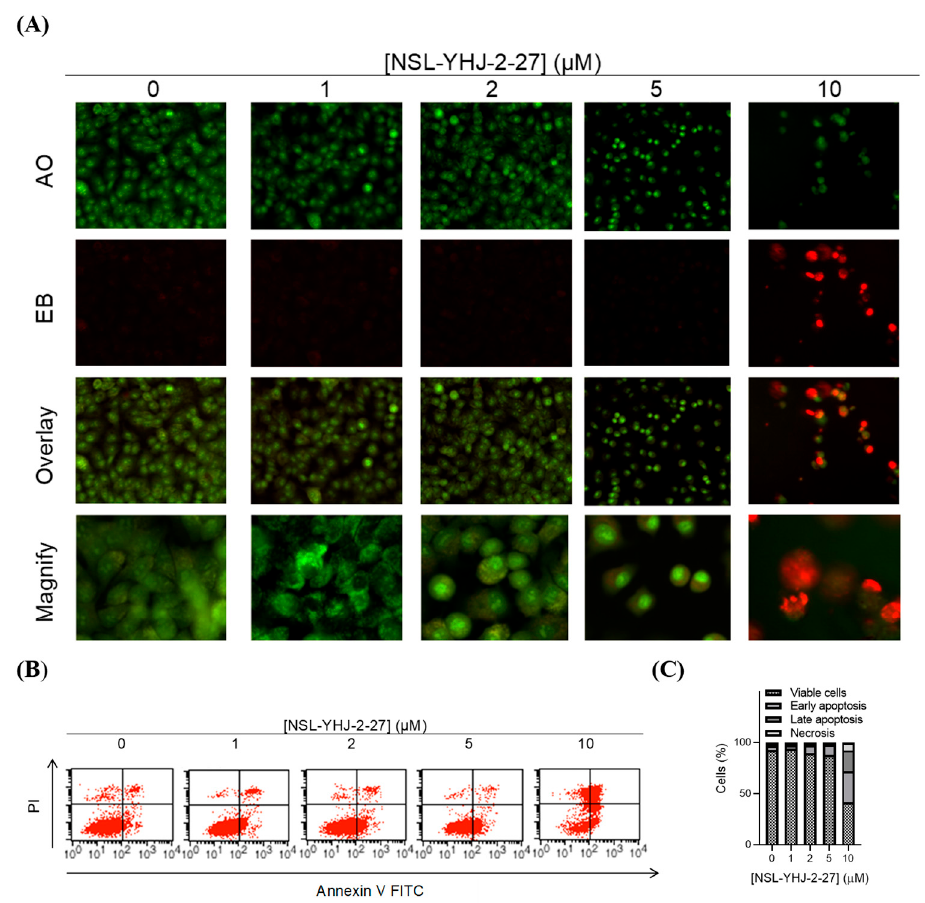
Figure 4. PCAIs induce apoptosis of A549 cells. A549 cells were treated with NSL-YHJ-2-27 (0–10 µ M) for 24 h. ( A ) Cells stained with AO/EB (100 mg/mL). Uniformly green color depicts live cells, while bright-green and red depict early and late apoptosis, respectively. ( B ) Cells stained with annexin V and propidium iodide and analyzed using flow cytometry as described in the methods. Live cells remain in the bottom left quadrant. Early and late apoptotic cells appear in the bottom right and top right quadrants, respectively. The top left quadrant is representative of cells undergoing necrosis. ( C ) Bar graphs showing the distribution of cells as determined by flow cytometry